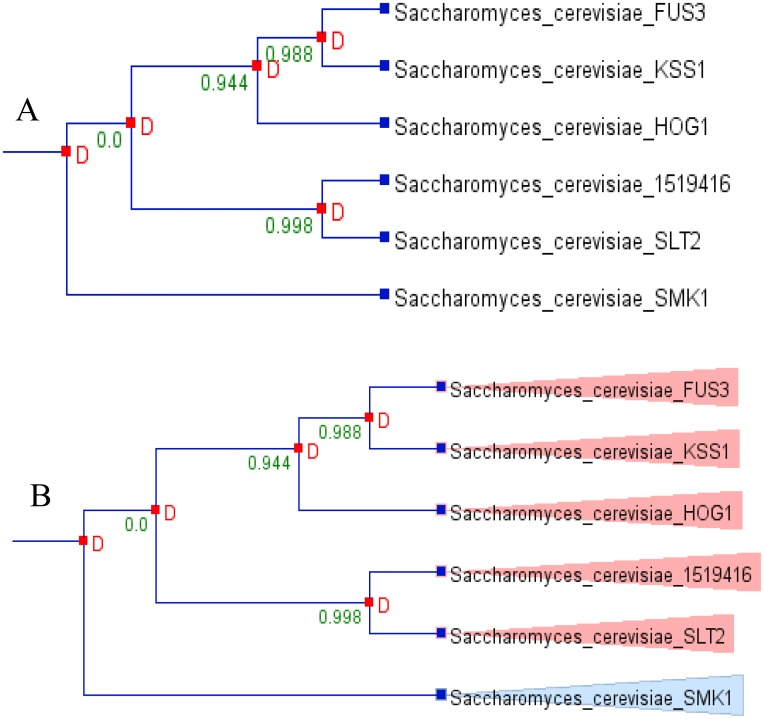
Duplication and orthologous/paralogous analysis of S. cerevisiae MAPKs.(A) Duplication analysis shows, S. cerevisiae MAPKs are highly duplicated. The duplicated MAPKs are Fus3, Kss1, Hog1, 1519416 (uncharacterized) and Slt2 and non duplicated MAPK is Smk1. (B) Orthologous/paralogous gene analysis shows, except Smk1, all other MAPKs are orthologs. The analysis was done using Notung 2.6 software.